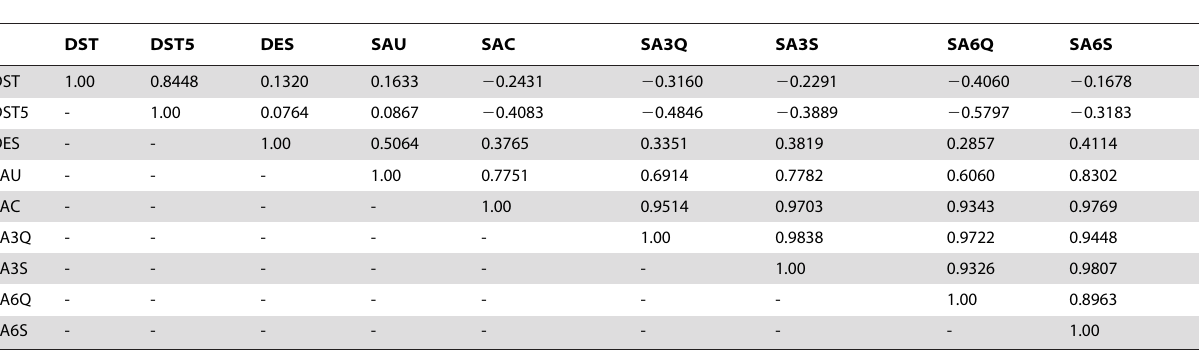
(DST: shortest travel time; DST5: average of 5 shortest travel time; DES: density; SAU: spatial accessibility index from the model without weighting parameter; SAC: spatial accessibility index from the model with continuous weighting parameter; SA3Q: spatial accessibility index from the zonal weighted model with 3 time zones and quick decay weighting; SA3S: spatial accessibility index from the zonal weighted model with 3 time zones and slow decay weighting; SA6Q: spatial accessibility index from the zonal weighted model with 6 time zones and quick decay weighting; SA6S: spatial accessibility index from the zonal weighted model with 6 time zones and slow decay weighting.); all coefficients are statistically significant.